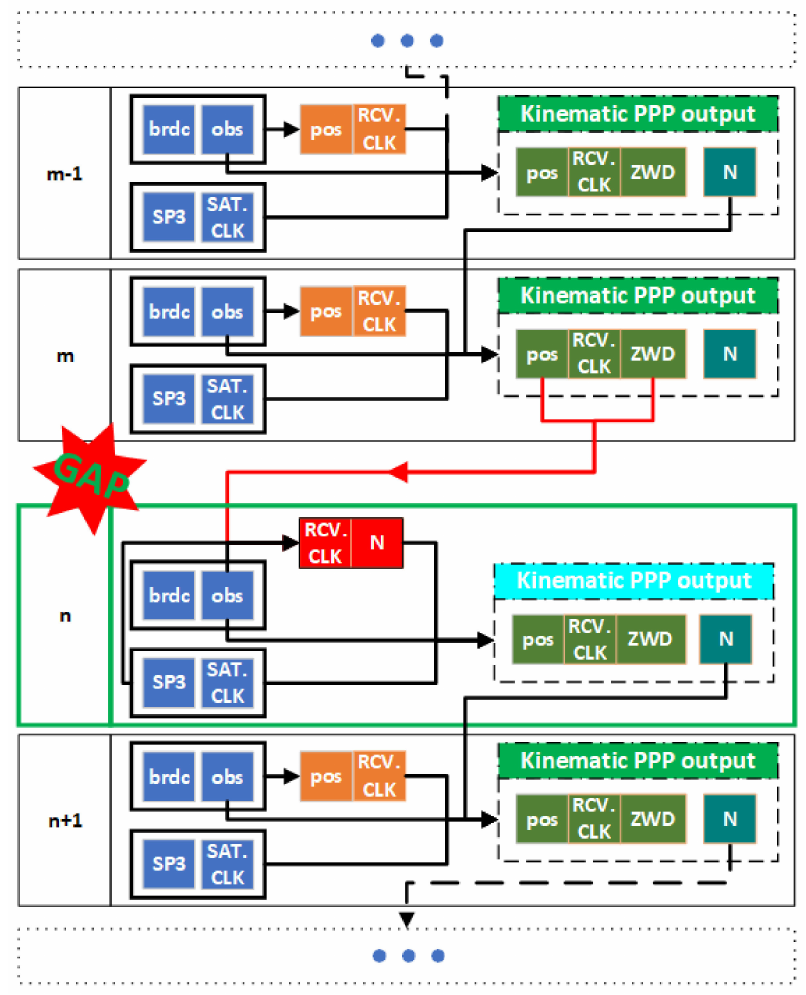
Figure 1. Flowchart of the PPP instantaneous convergence strategy during a data gap. The data gap occurs between epochs m and n. The precise position and ZWD at epoch m can be used as constraints for partial parameters estimation at epoch